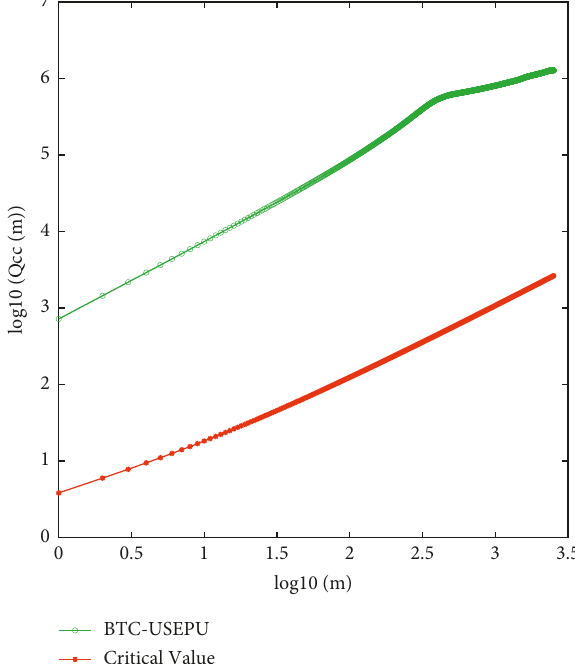
Figure 3: Log − log plot of Q